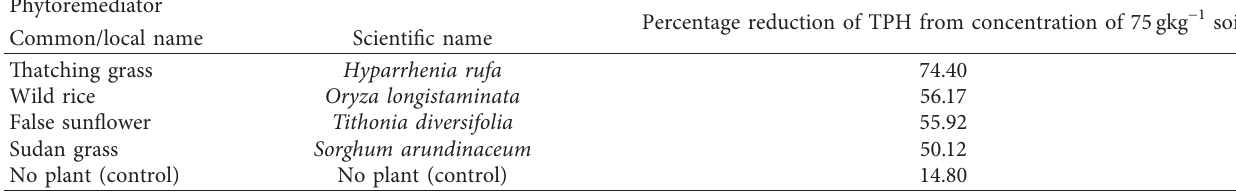
Table 1: Sudd region phytoremediators of petroleum hydrocarbon.